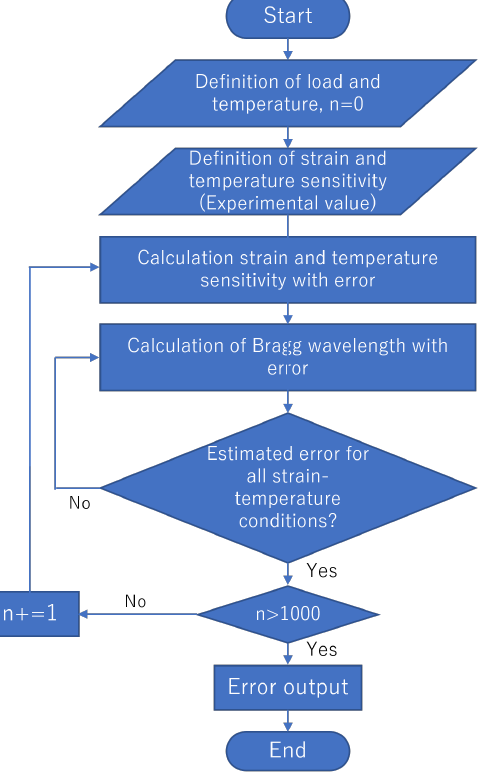
Figure 10. Flow of the error output when using the Monte Carlo